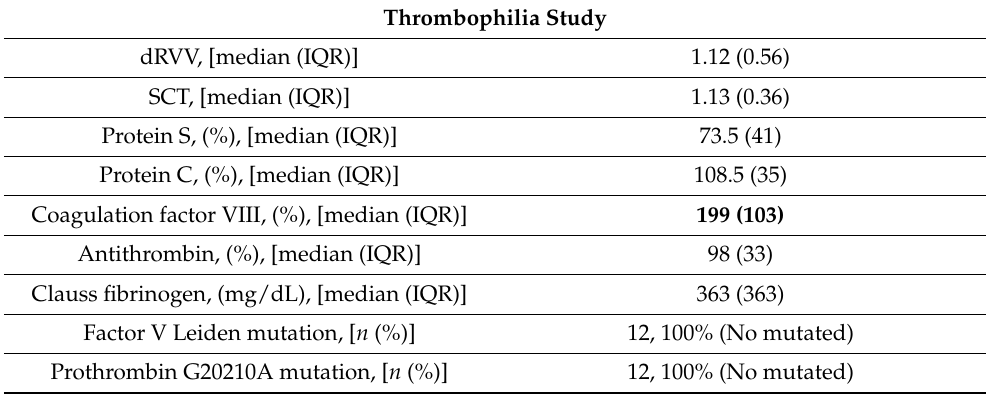
Table 3. Description of the results of the thrombophilia study ( n = 12) performed after acute viral